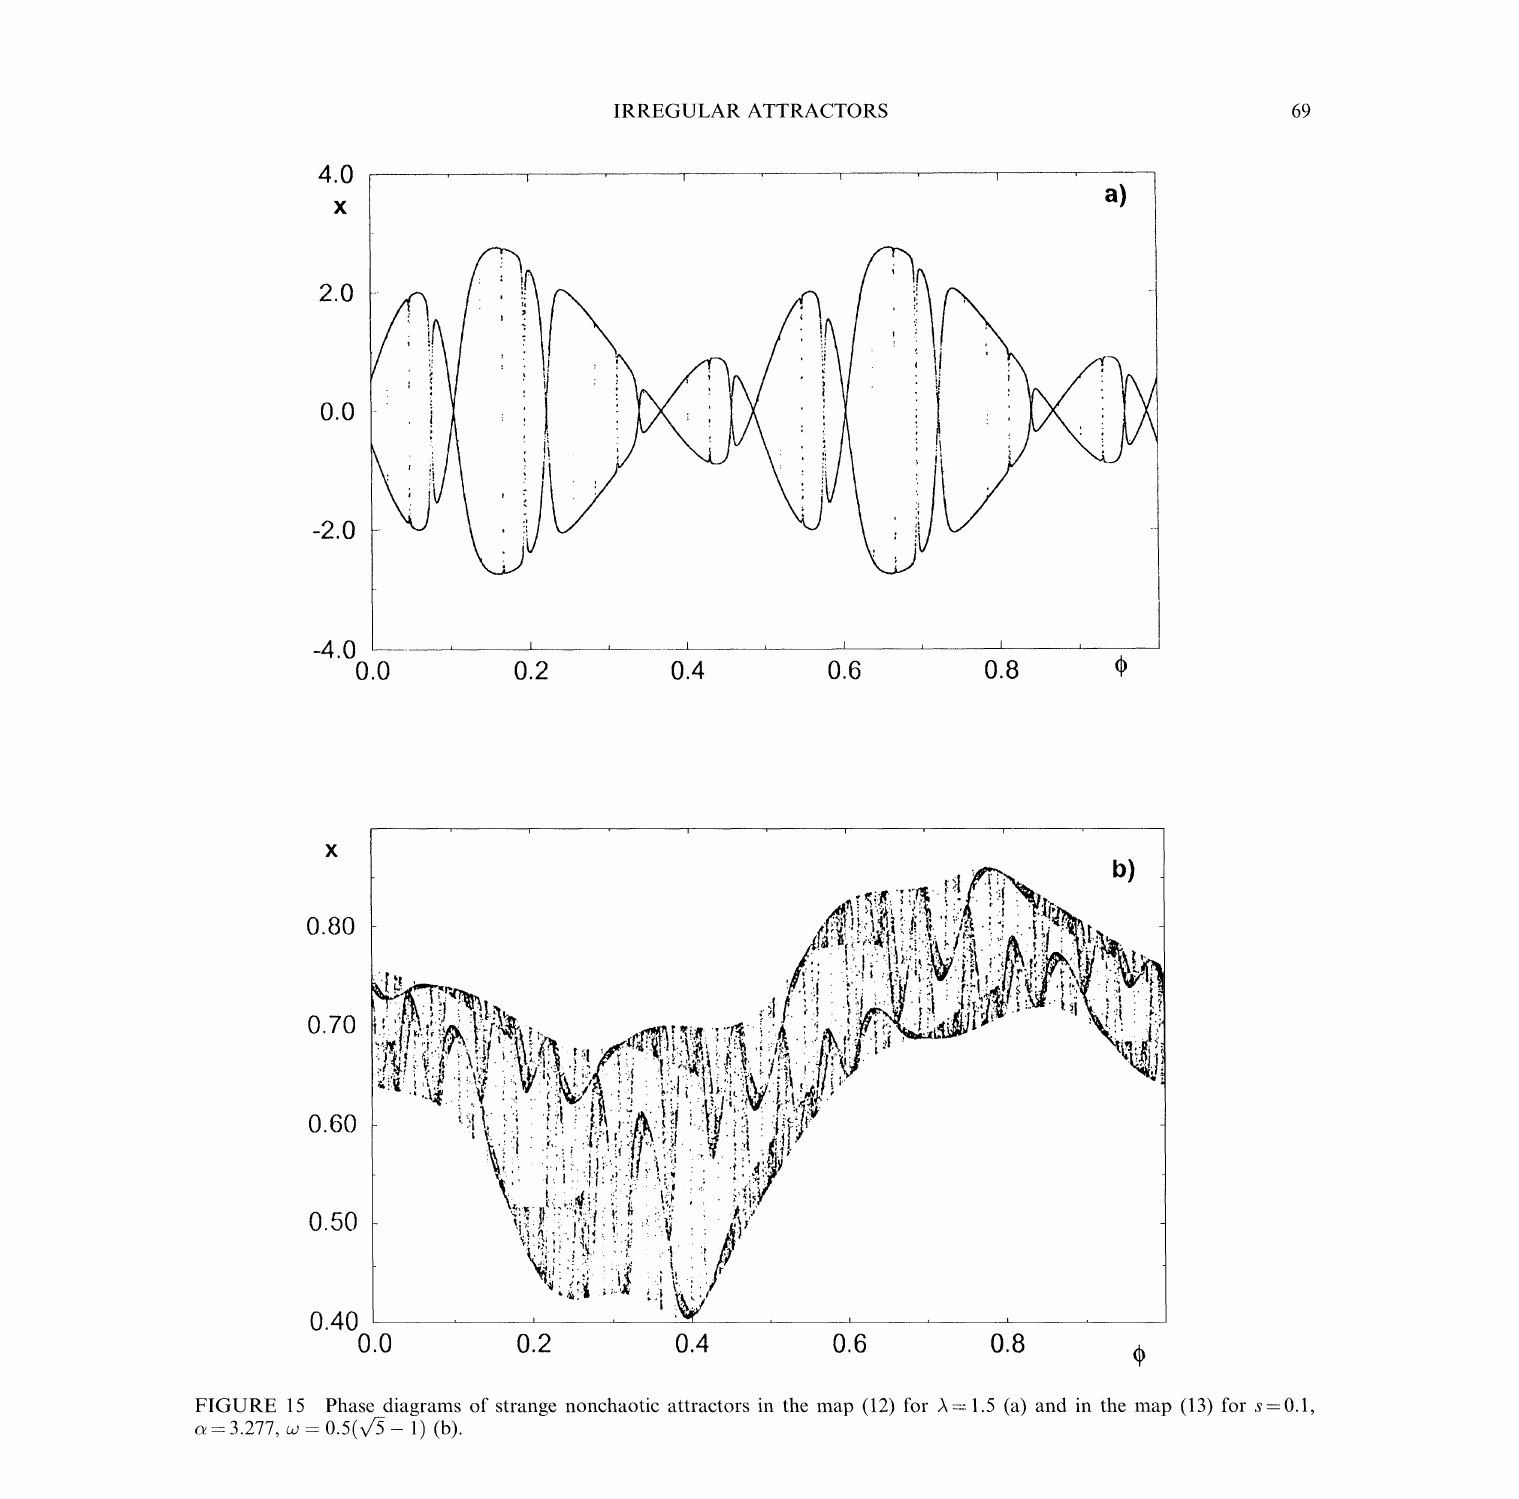
FIGURE 15 Phase diagrams of strange nonchaotic attractors in the map (12) for oz 3.277, co